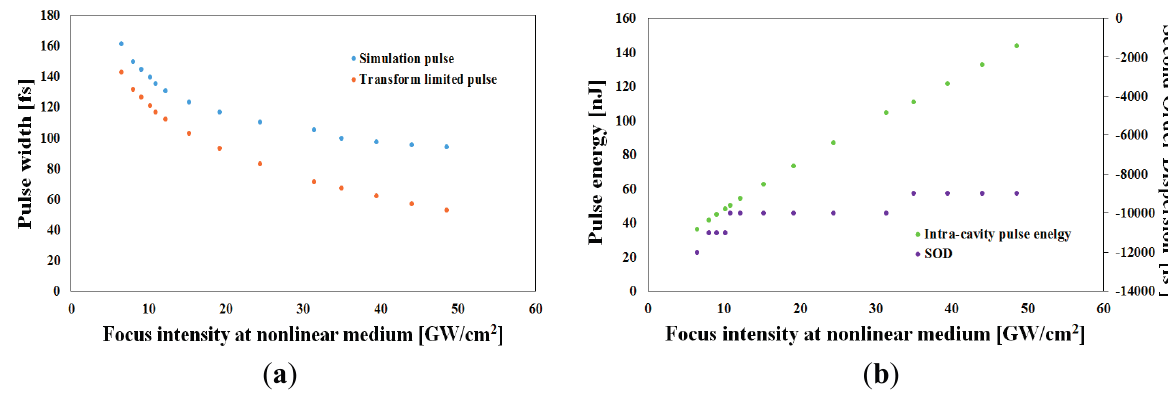
Figure 7. ( a ) Output pulse width and the Fourier transform-limited pulse width of the output spectrum; ( b ) Pulse energy and SOD for the shortest pulse